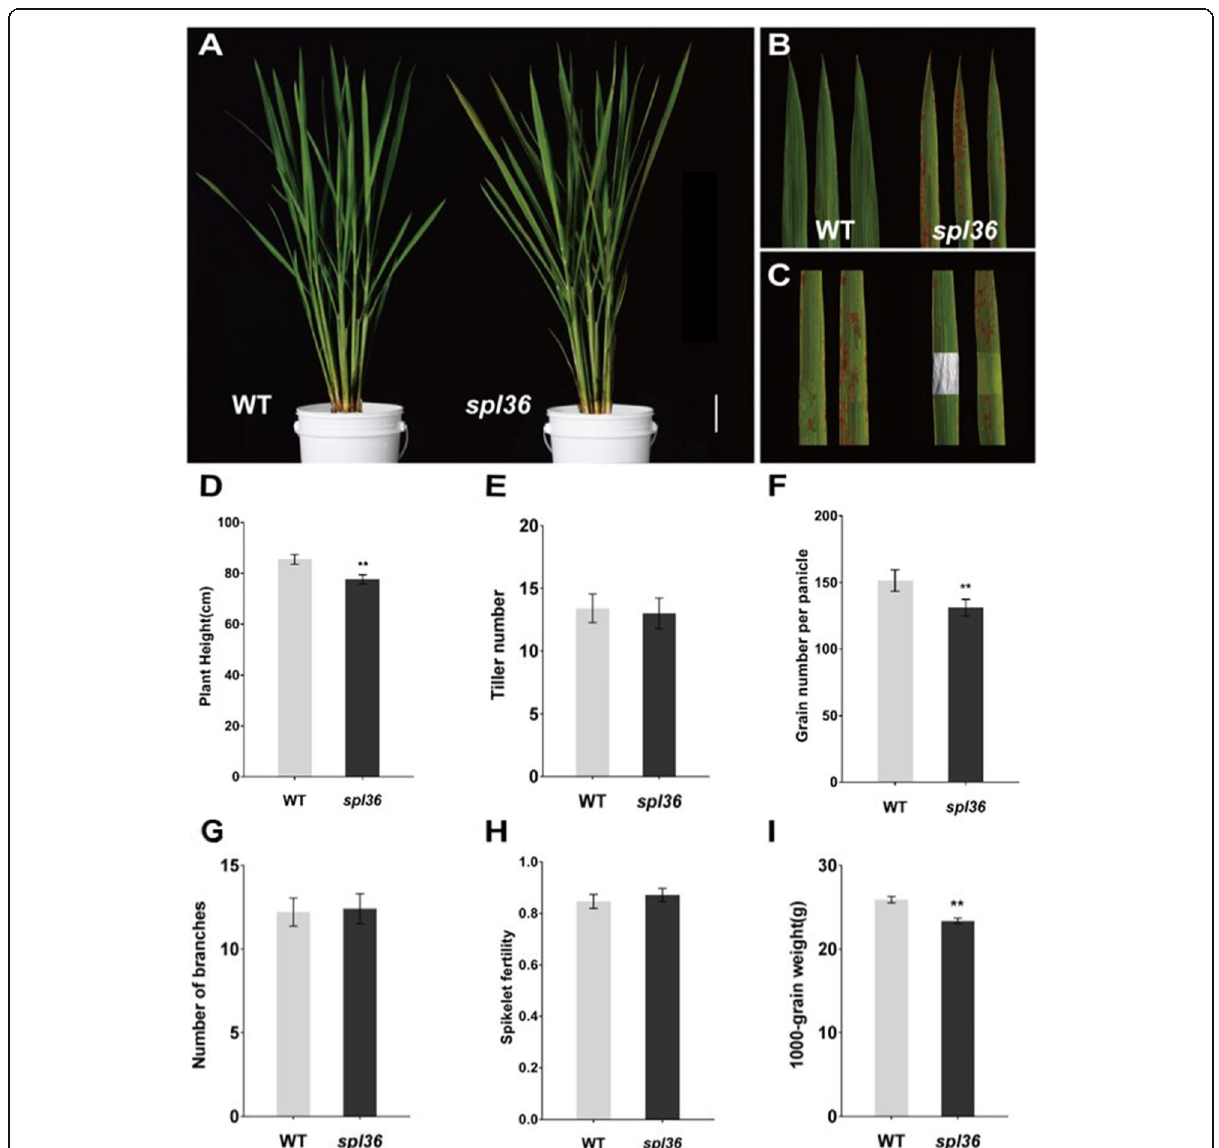
Fig. 1 Phenotypes of the spl36 mutant. a Lesions appear at the tillering stage. Bar = 6 cm. b Lesions first appear at the tip of the leaf (WT and spl36 at the tillering stage). c Effect of light on lesion formation under natural conditions; spl36 before shading (1,2). spl36 shaded for 7 days (3,4). d-i Statistical analysis of important agronomic traits in WT and spl36 at the maturity stage. Values are means ±SD ( n = 10); ** indicates significance at P ≤ 0.01 by Student ’ s t